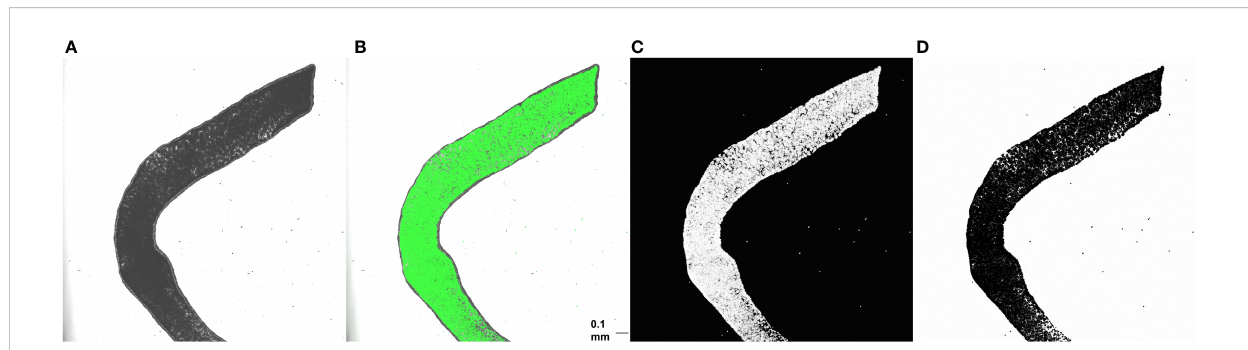
FIGURE 1 Bright fi eld (A) , overlay (B) , fl uorescent (C) , and inverted binary (D) images of one anemone tentacle mounted on a plain slide. Scale bar = 0.1 mm. ImageJ was used to quantify algal area fraction in binary images. A region of the tentacle containing only gastrodermal cells was fi rst outlined using the freeform tool, and area fraction was then determined using the measure